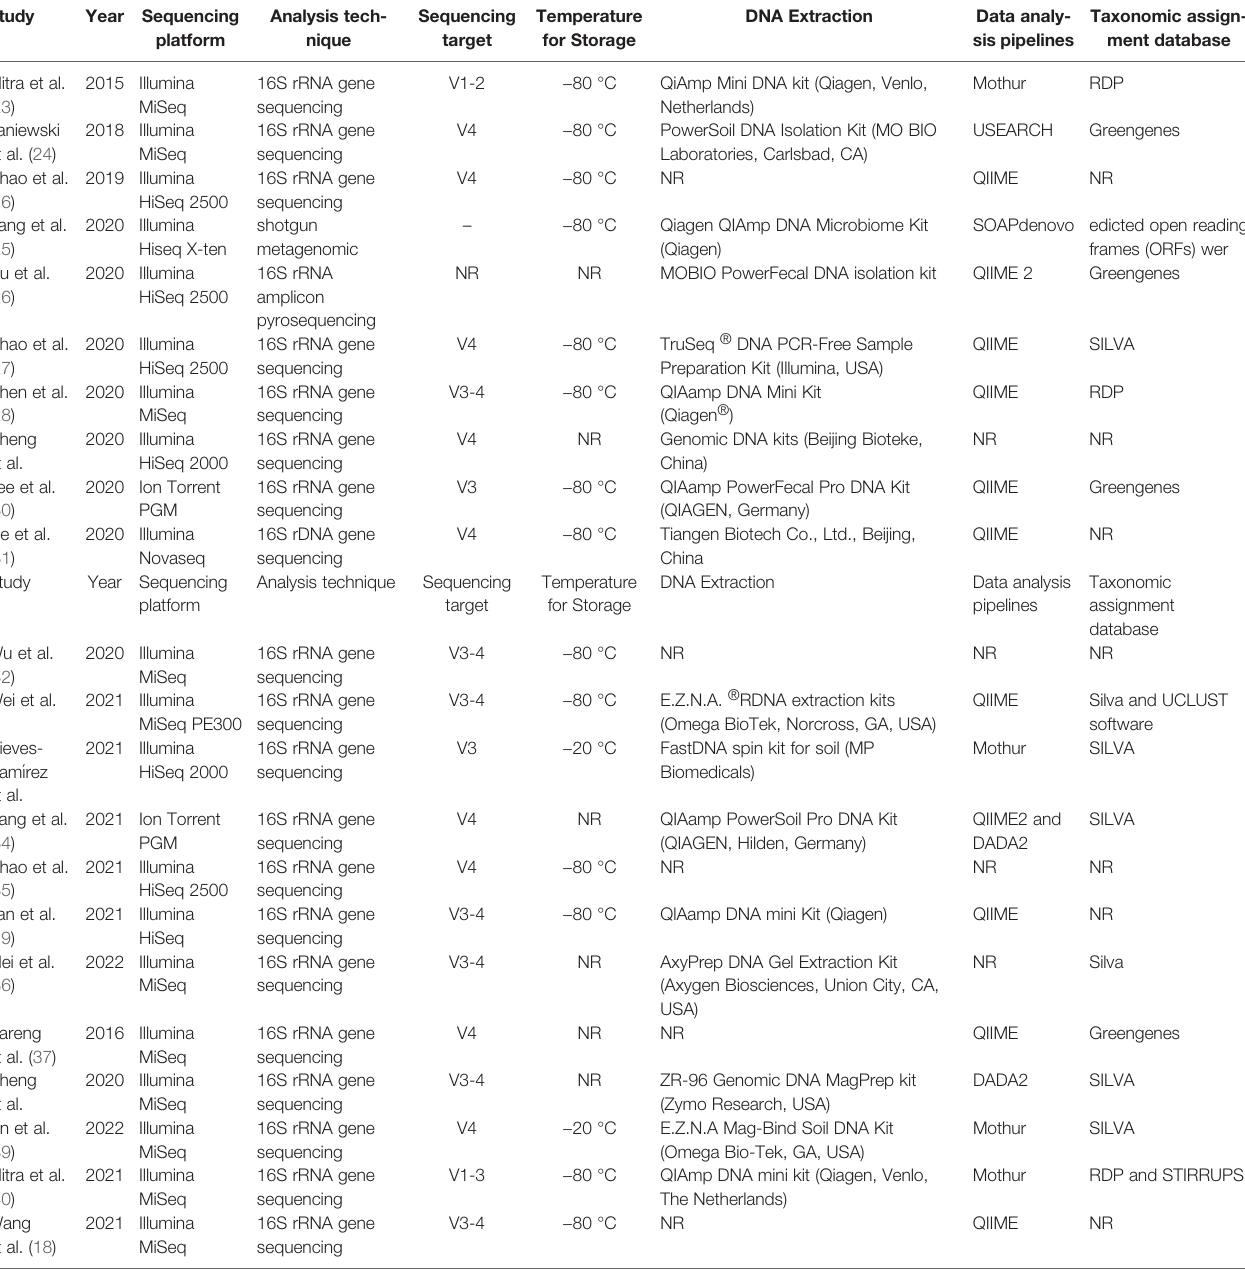
TABLE 2 | Microbiome methodology of included